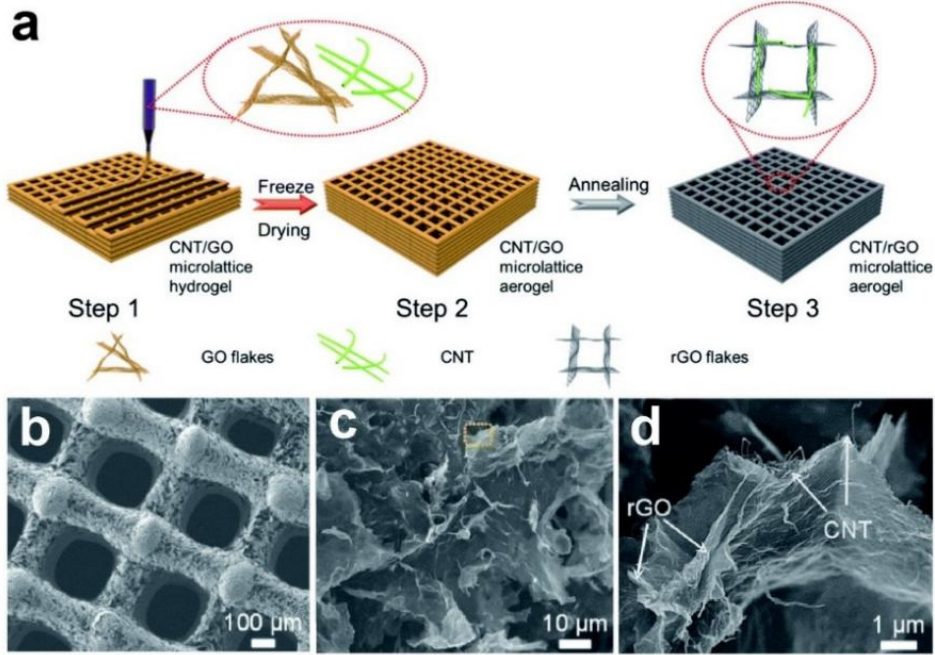
Figure 8. ( a ) The flow diagram illustrates the fabrication procedure of the printed